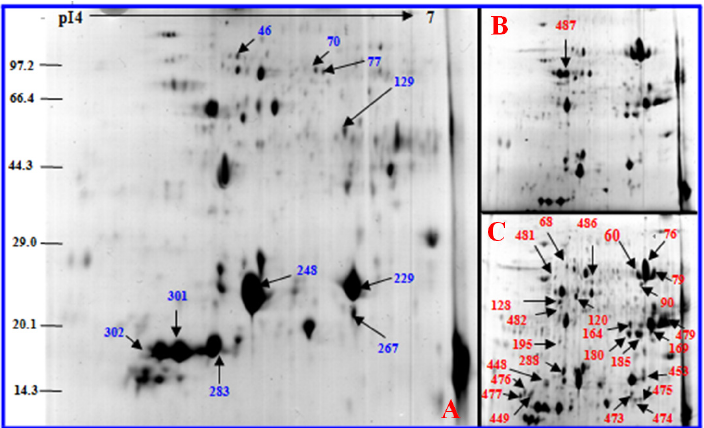
Figure 10. Coomassie Brilliant Blue (CBB)-stained two-dimensional electrophoresis gels of proteins from Robinia pseudoacacia tetraploid (4×) leaves. Proteins were separated on 13 cm IPG strip (pH 4–7 linear gradient) using isoelectric focusing, followed by sodium dodecyl sulfate polyacrylamide gel electrophoresis on a 12.5% gel. ( A ) 1-day NaCl-treated leaves; ( B ) 5-day NaCl-treated leaves; ( C ) 10-day NaCl-treated leaves. Blue and red numbers indicate proteins that increased and decreased between control and stressed samples, respectively. The proteins are listed in Table 2.